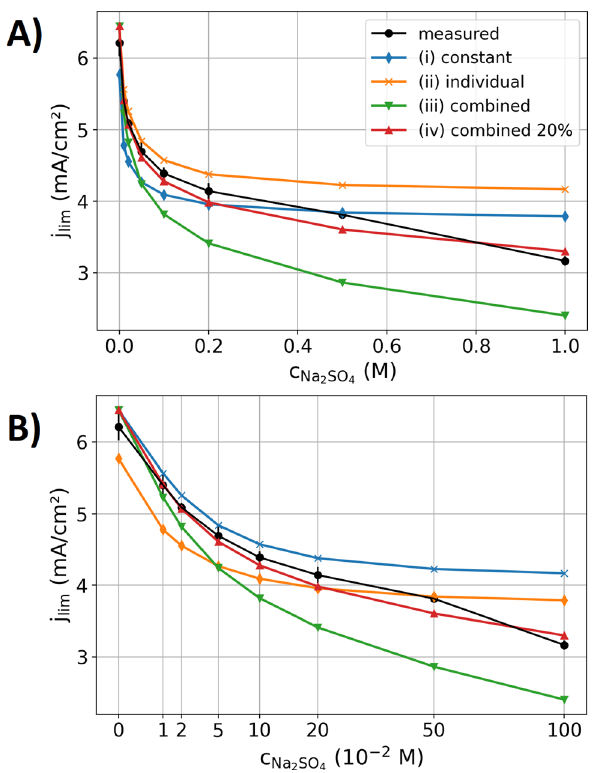
Figure 4. Measured (black lines with scatter and error bars) and modeled (colored lines) limited currents densities for a CuSO 4 concentration of 0.1 M under a variation of the Na 2 SO 4 concentration. The four different parameterization scenarios for the model are discussed in the text. The measured data is recorded with a voltage of 0.3 V between the electrodes. ( A ) Linear increment of the x-axis. ( B ) Square root spacing of the x-axis to more clearly resolve the limited current densities at small